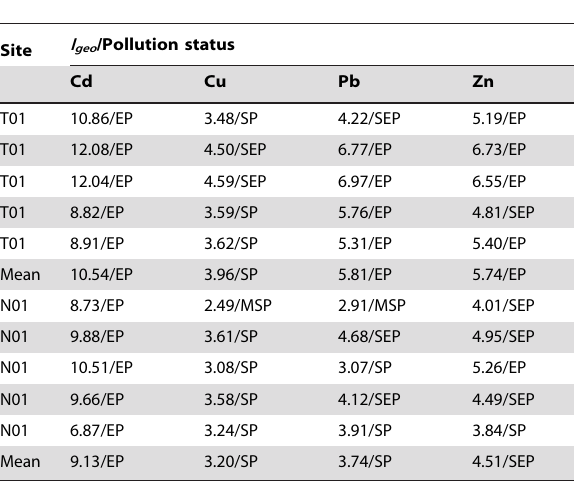
Table 5. Heavy metal geo-accumulation index ( I geo ) in soil and sediment samples from Xiawangang River.